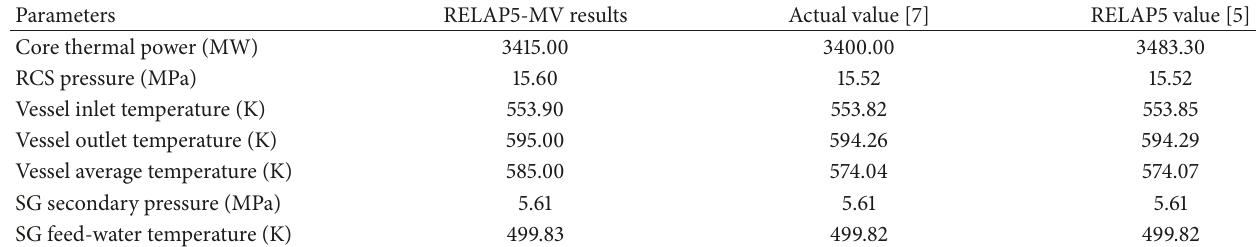
Table 2: Steady-state calculated results of AP1000 obtained by the RELAP5-MV.